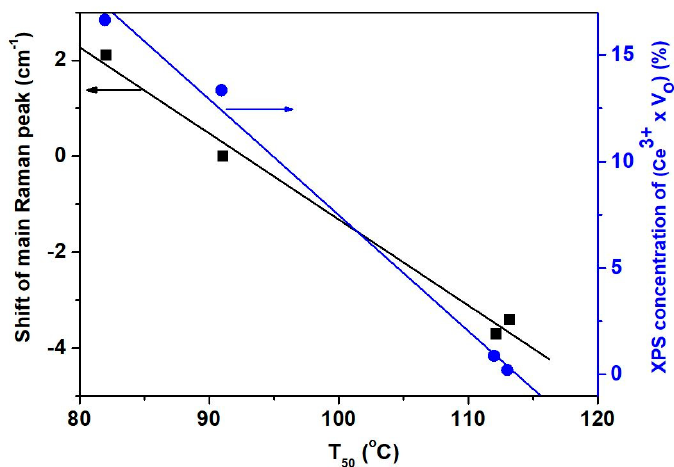
Figure 20. T 50 vs. (i) shift of the main peak (F 2g Raman vibration mode) of fluorite CeO 2 and (ii) surface concentration of Ce 3+ and oxygen vacancies determined via XPS analysis. Adapted from Reference [278]. Copyright © 2018, John Wiley and